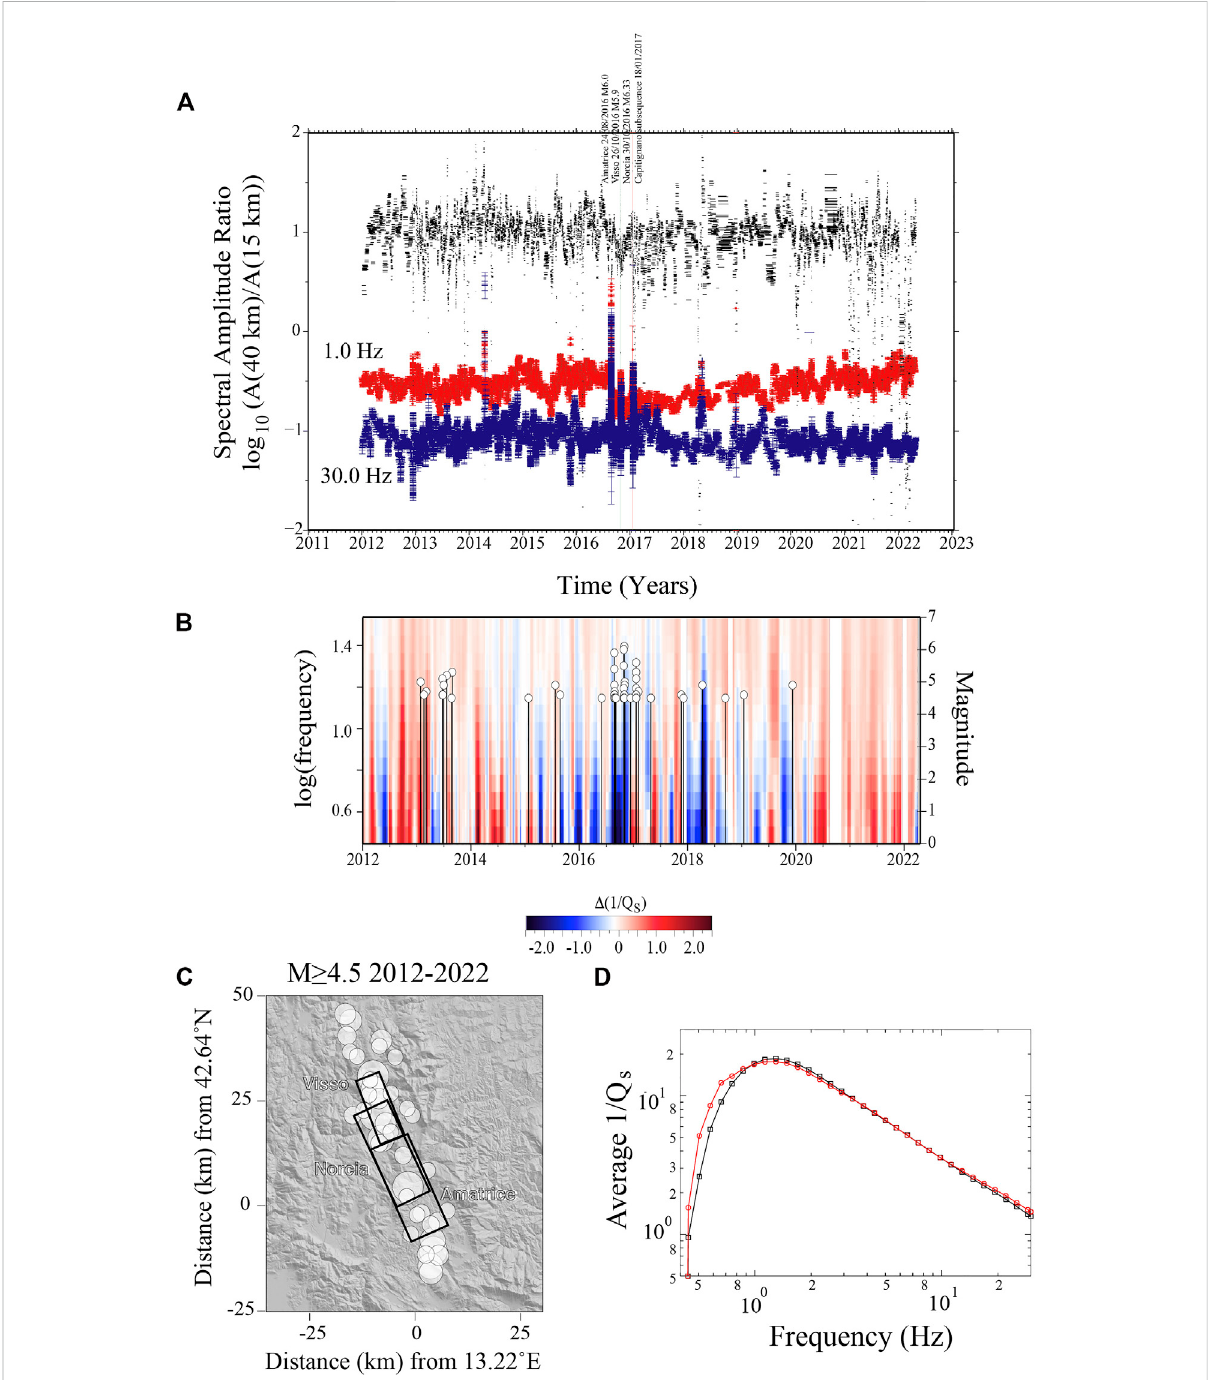
FIGURE 4 (A) Colored symbols: logarithm (base 10) of total attenuation (geometric and anelastic) calculated as a spectral amplitude ratio between the hypocentraldistancesof15and40 km:before,during,andafterthe2016 – 2017sequence.Minuscule,horizontalblacksegmentsrepresentthedurations of all the m time windows (each one contains 40 events) used to scan the entire period. Horizontal black segments go up and down in order not to overlap; no physical meaning to their elevation: they just follow (ampli fi ed) the fl uctuations of the 1 Hz attenuation time series. Indicated are the times of occurrence of the main shocks of Amatrice, Visso and Norcia. Note the different behaviors shown by the total attenuation at 1.0 and 30 Hz: whereasthehigh-frequencytimehistorystaysrelativelyconstantthroughouttheentireperiod,the1-Hzoneischaracterizedbyasharpdecreaseatthe onset of the Amatrice main shock, followed by a linear trend of recovery (exponential healing) that appears to be still going on in mid-2022. (B) 2-D representationoftheattenuationparameter Q − 1 S ( t , f ) ,whichindicatedthemagnitudesandtimesofoccurrenceofeventswith M ≥ 4.5.Thefrequencyaxis isinlogscale. (C) Epicentrallocationsoftheeventswith M ≥ 4.5indicatedin (B) .Rectanglesindicatetheapproximaterupturesofthethreemainshocksof the sequence. (D) Time-averaged attenuation parameters 〈 Q − 1 S ( f ) 〉 calculated in the pre-Amatrice time window (07 January 2013 through 23 August 2016, black line and symbols), and in the post-Amatrice one (24 August 2016 through 20 August 2020, red line and